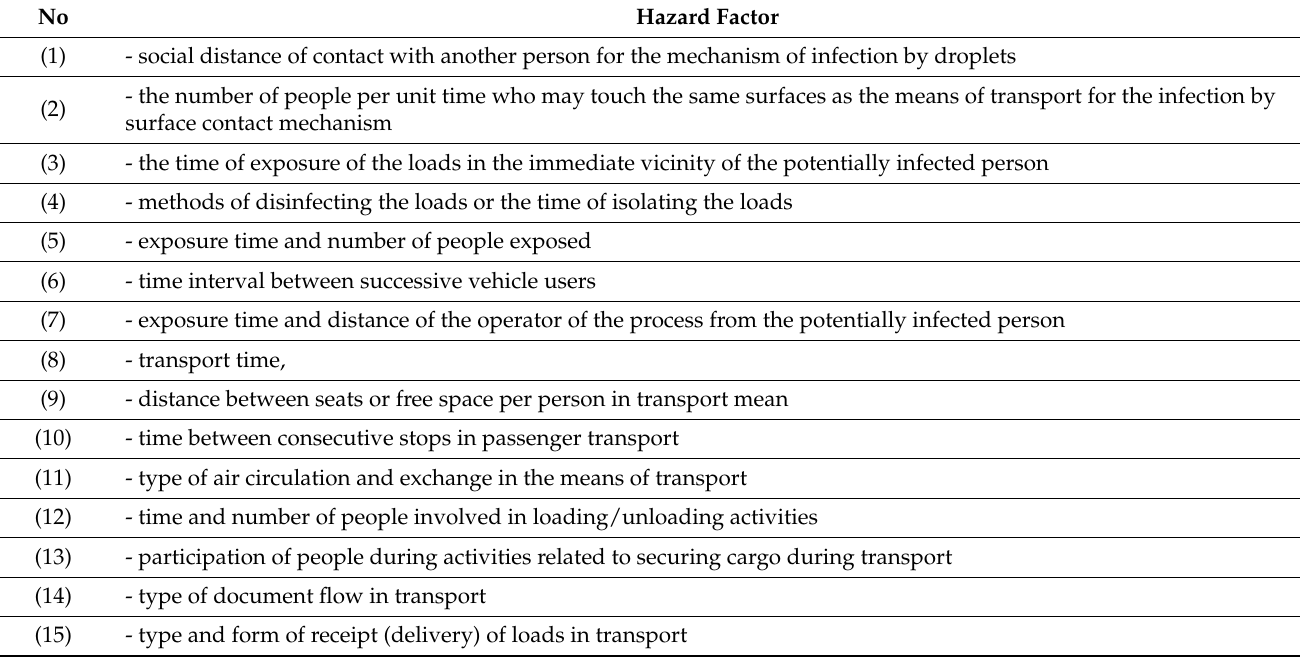
Table 1. Factors that affect epidemic hazards in